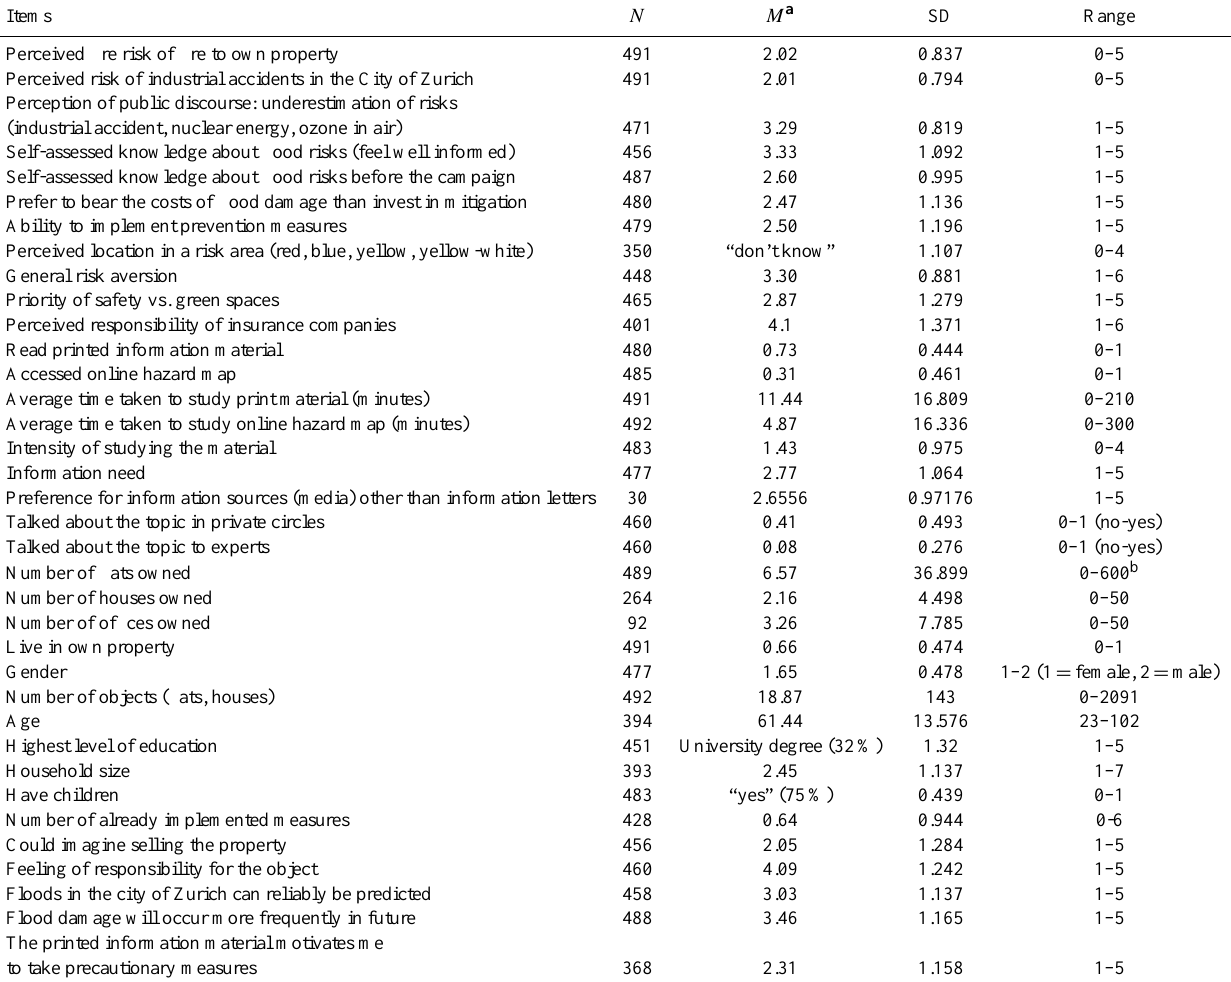
Table A1. Single items in the questionnaire (not used for scale